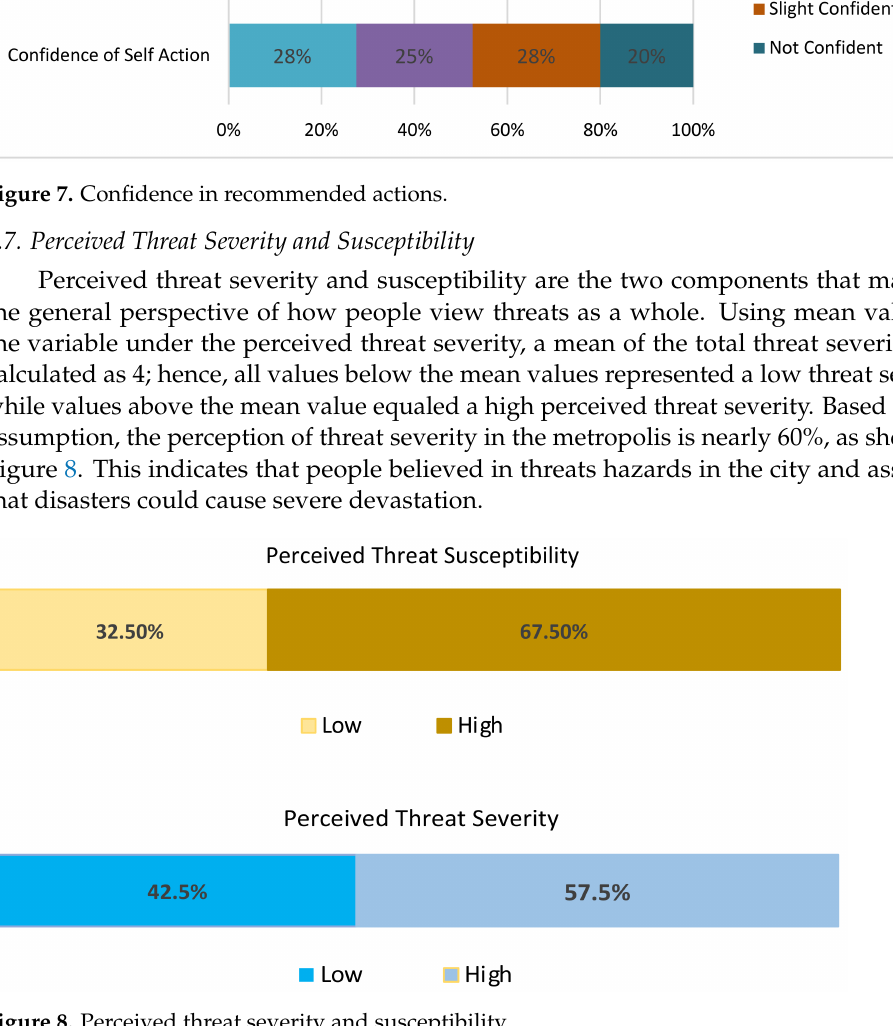
Figure 8. Perceived threat severity and